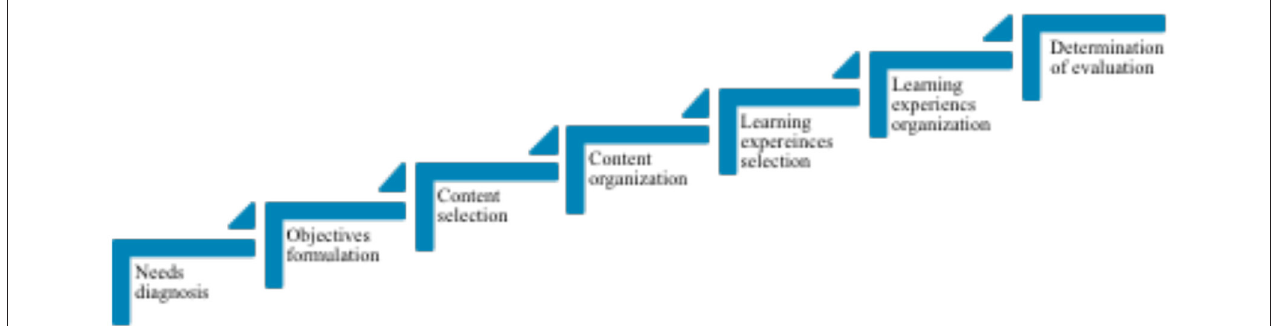
FIGURE 2 | Taba’s (18) curriculum planning model.